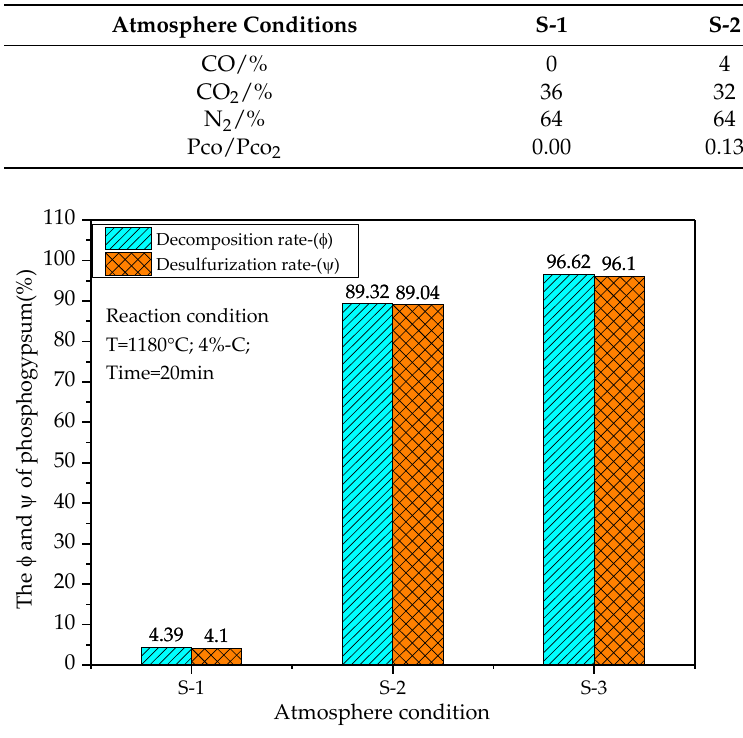
Figure 9. Effect of solid–gas and solid–solid reactions on phosphogypsum decomposition process.